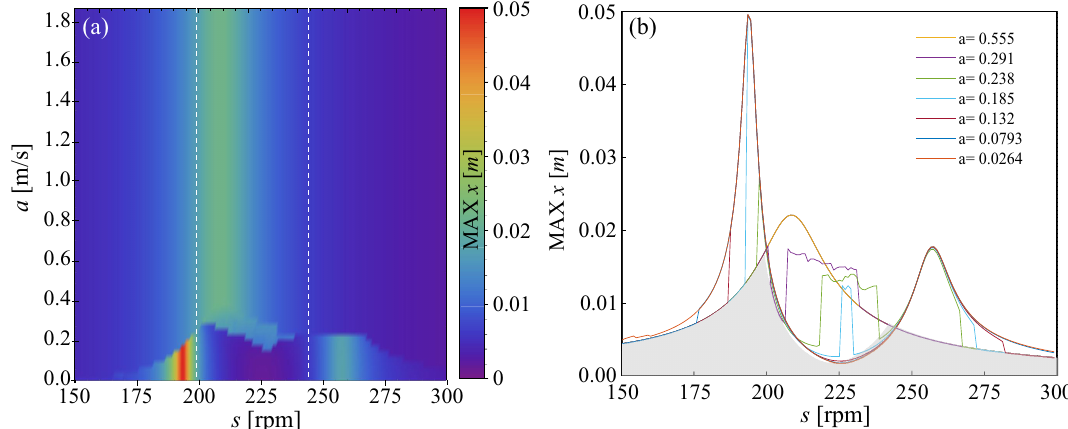
Figure 10. In panel ( a ) we show two dimensional plot of maximum amplitude of damped system (max x [ m ] ) in two parameters of space: a and s for damping function given by equation (Equation (10)). Panel ( b ) shows seven exemplary FRCs of damped